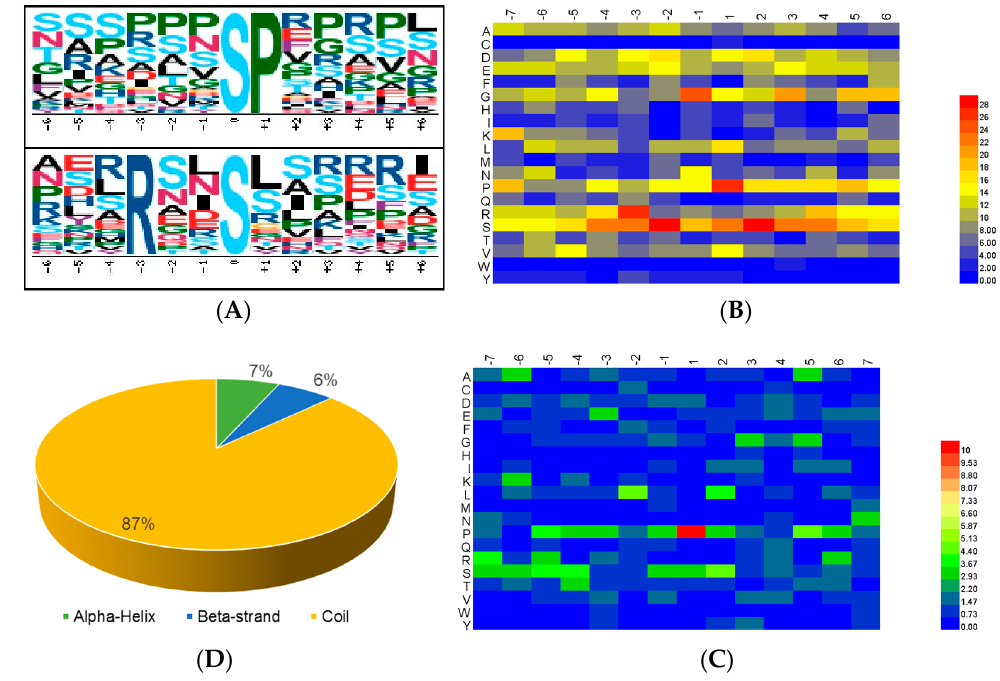
Figure 3. Analysis of phosphorylation sites by sequence motif, the distribution of amino acids in the flanking sequences and structural preferences in the differentially-expressed phophopeptides in A. mongolicus roots under drought stress. ( A ) The sequence motif analysis of phosphorylation sites using Motif-x; ( B ) the heatmap for the distribution of amino acids in serine phosphorylation site flanking sequences; ( C ) the heatmap for the distribution of amino acids in threonine phosphorylation site flanking sequences; and ( D ) the secondary structural distribution for the phosphorylation sites.